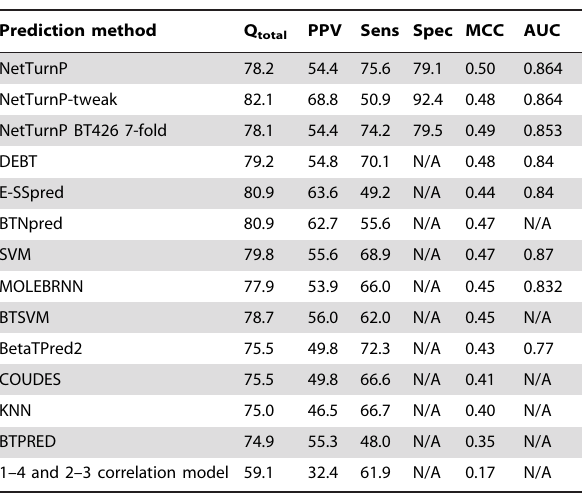
Table 1. Comparison of NetTurnP with other b -turn prediction